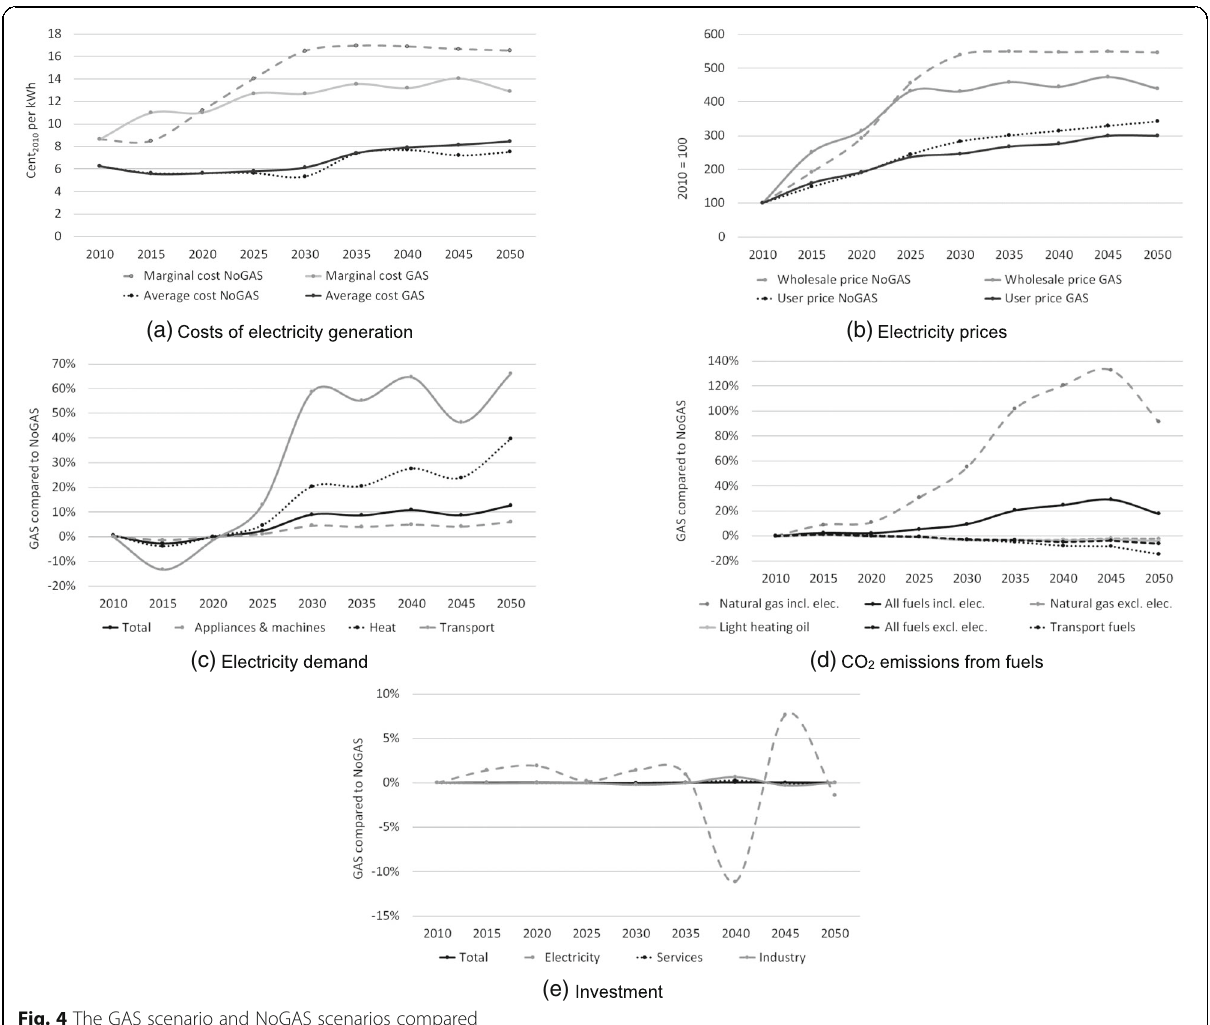
Fig. 4 The GAS scenario and NoGAS scenarios